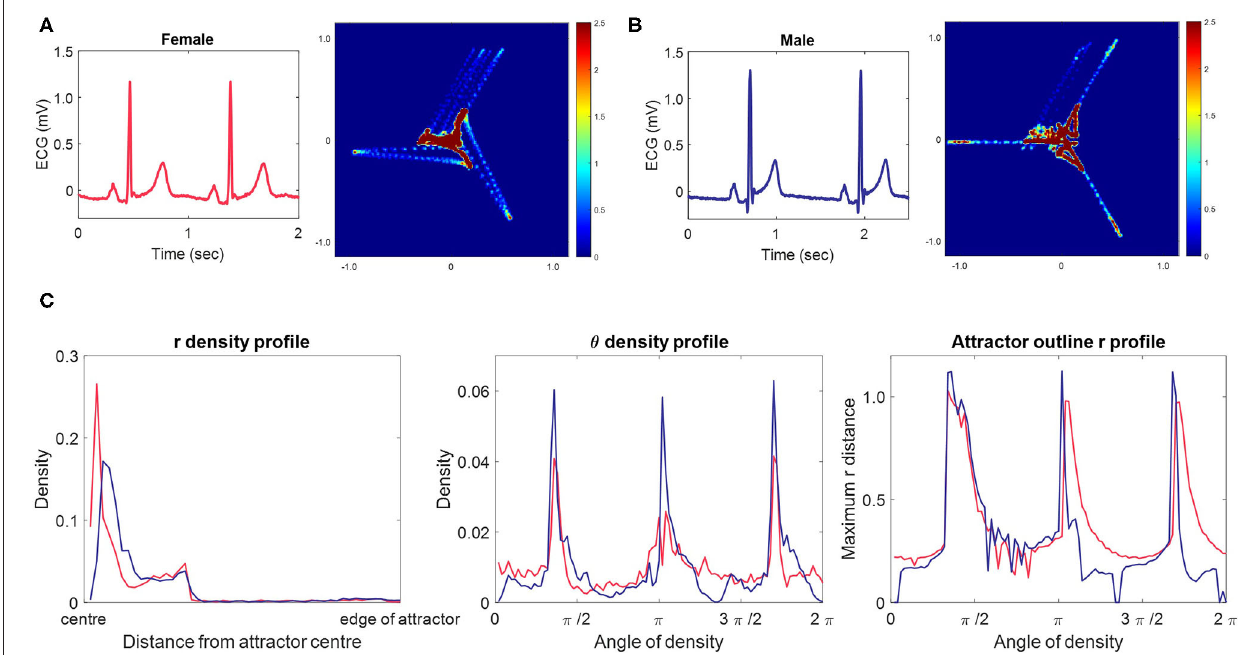
FIGURE 2 | Typical female and male ECG signals, their corresponding 3-point attractors and attractor measure set profiles. (A, B) A 2 second excerpt from 10 second lead II signals from a typical female (A) and male (B) lead II signal with their corresponding 3-point attractors. Small differences in the appearance of the signals are amplified in the attractor. The overall appearance of the female attractor is one of a more dispersed distribution with wider arms, whereas the male attractor shows higher density, narrow arms. We also observe that the upper arm of both attractors is more variable than the other two arms. For both subjects, this is the result of the beat-to-beat variation in the T to P (interbeat) interval. (C) The measure set profiles associated with the attractor images in (A) [female, red] and (B) [male, blue.] The three measure sets quantify the attractor images, and we can clearly see differences between the female and male measures. The r density profile shows that both attractors have their points concentrated in the first third of the attractor moving out from the center, but that the density peak is more central and greater in the female attractor. The θ density indicates that although each attractors most dense parts lie at the same angle from the center, they are of lower density in the female attractor. The attractor outline r profile indicates that the male attractor is slightly larger than the female one and highlights that both attractors reflect beat-to-beat variability in their upper